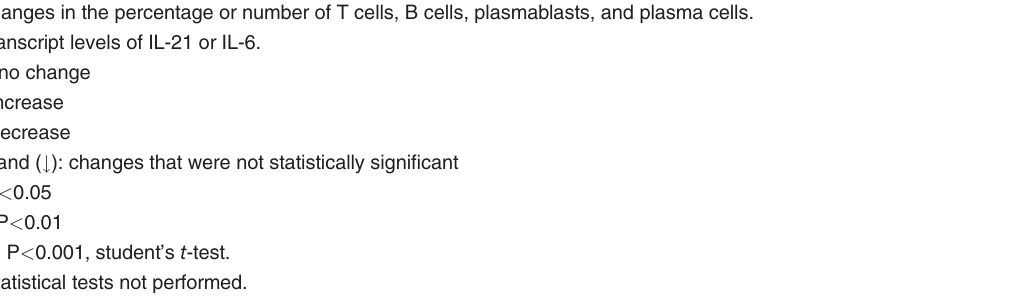
more antibody production (Fig. 5A), increased number of plasma cells in the spleen (Fig. 5B), and heightened production of B cell-activating cytokines in MRL/lpr mice (Fig. 5C and S3A Fig.). Second, tRA increased the accumulation of leukocytes in the brain (Fig. 2A), lung (Fig. 2B), and tubulointerstitium region of the kidney in the same lupus-prone mice (Fig. 3A- C), potentially by facilitating leukocyte trafficking into these tissues and promoting local inflammation. Importantly, tRA failed to induce such inflammation in the absence of a predis- posed (Fig. 7 and S4 Fig.). In addition, we found that retinol storage in the liver was significant- ly lower in MRL/lpr than MRL mice (S1A Fig.). Although the level of retinol in lupus-affected organs was not determined, we speculate that more retinol may have been depleted from the liver in order to facilitate immune response in other organs, thereby promoting lupus-like dis- ease in MRL/lpr mice. Together, these results suggest that although tRA is able to improve glo- merular pathology and reduce the size of lymph nodes in the mesenteric area, it has a generally